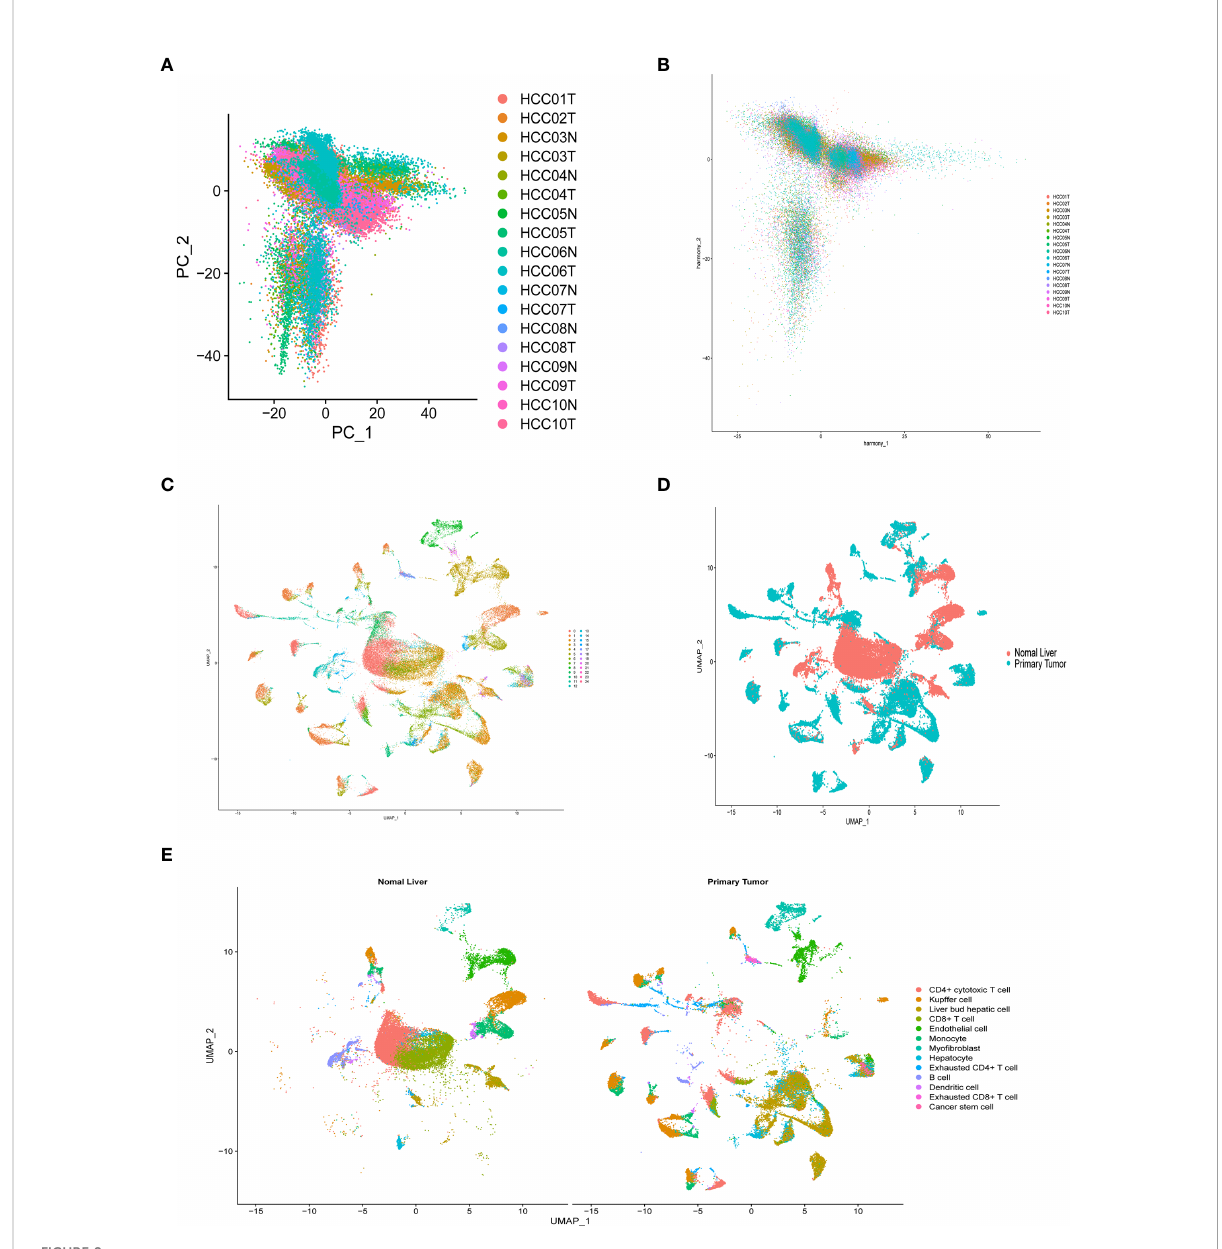
FIGURE 8 Overview of single cells from tumor samples and normal samples. (A) dimensionality reduction graph of two different types of samples. (B) Multi-data integration to remove batch effects of two different types of samples. (C) UMAP of the 25 cell clusters. (D) The sample types of the cells. (E) The cell types were identi fi ed by marker